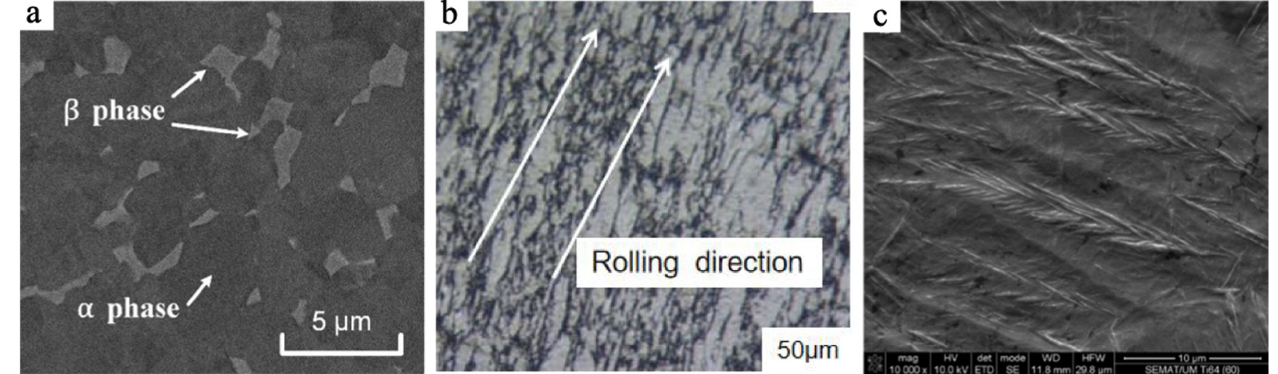
Figure 1. SEM images of Ti6Al4V obtained by ( a ) cold rolling, ( b ) hot rolling and ( c ) Laser Powder Bed Fusion (adapted with permission from [3,34,35]. Copyright 2016 Elsevier).